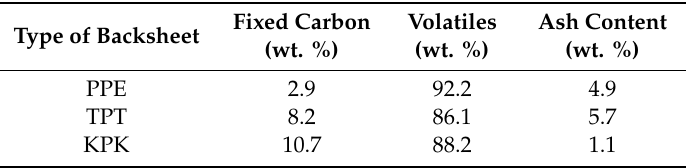
Table 1. Proximate analysis of backsheet samples.